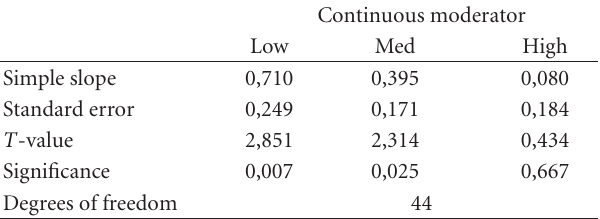
Table 10: Simple slope analysis.